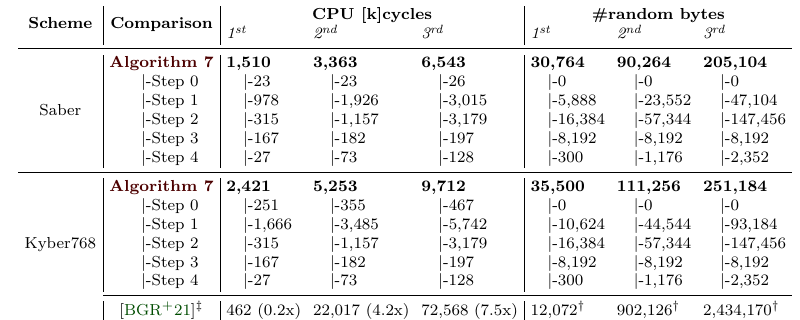
Table 2: Performance breakdown of our masked comparison on ARM Cortex-M4 with collision probability 2 − s = 2 −